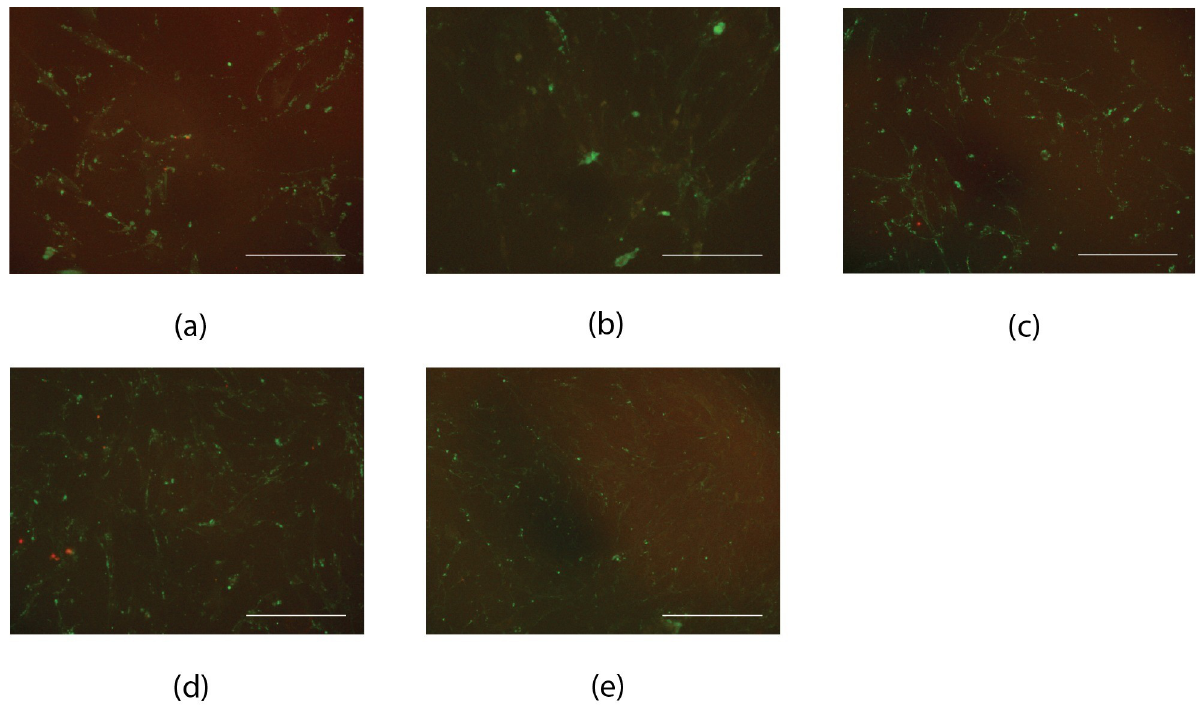
Fig 3. UEA lectin 1 binding and acetylated-LDL uptake for iECs. UEA lectin 1 (green) and acetylated-LDL (red) for (a) Neonatal-derived iECs; (b) Patient 1; (c) Patient 2; (d) Patient 3; (e) Patient 4. Scale bars are 500 μ m.